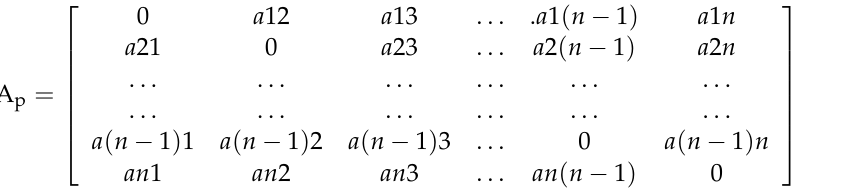
Table 4. The correspondence of the DEMATEL scale. Linguistic Terms Numerical Value No influence 0 Very low influence 1 Low influence 2 High influence 3 Very high influence